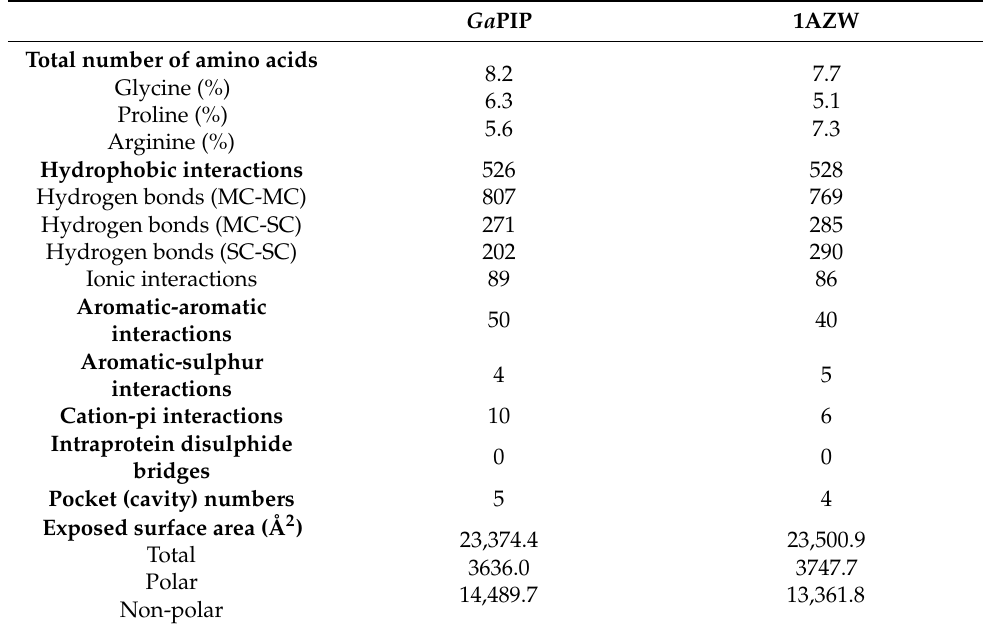
Table 2. Structural and interaction comparison between Ga PIP (5YHP) and